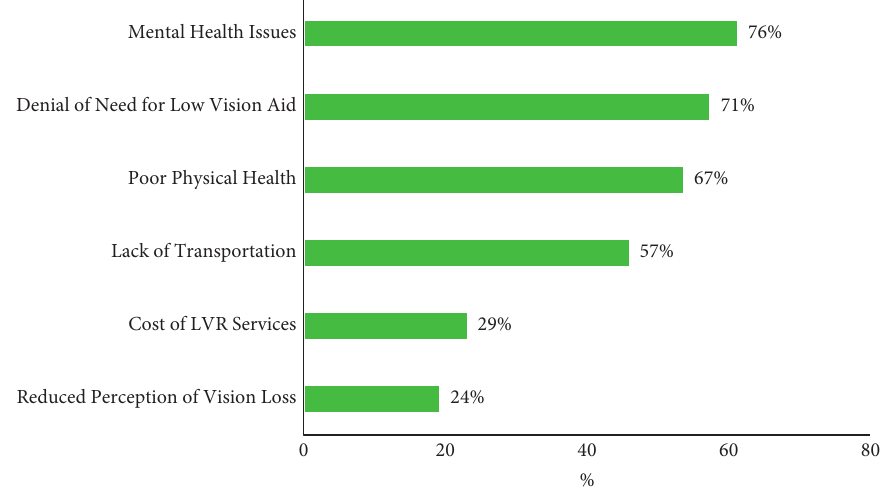
Figure 4: Barriers to low-vision rehabilitation services from the questionnaire evaluating patient experiences. LVR � low-vision